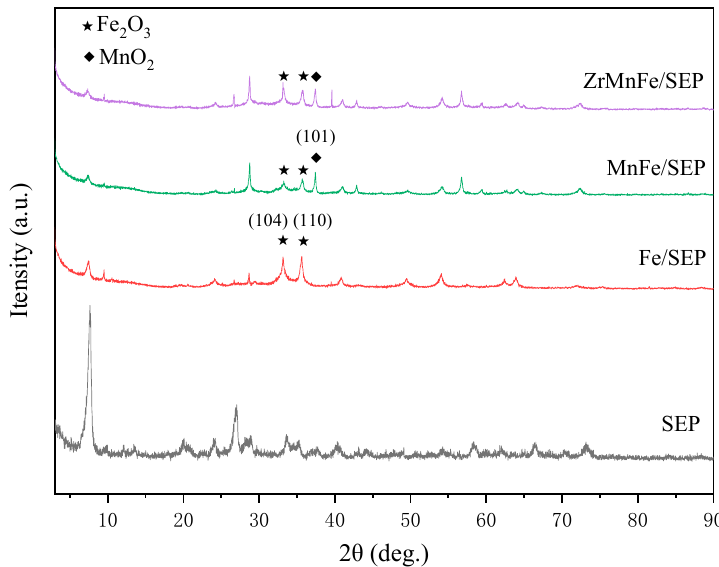
Figure 4. XRD pattern of ZrMnFe/SEP.